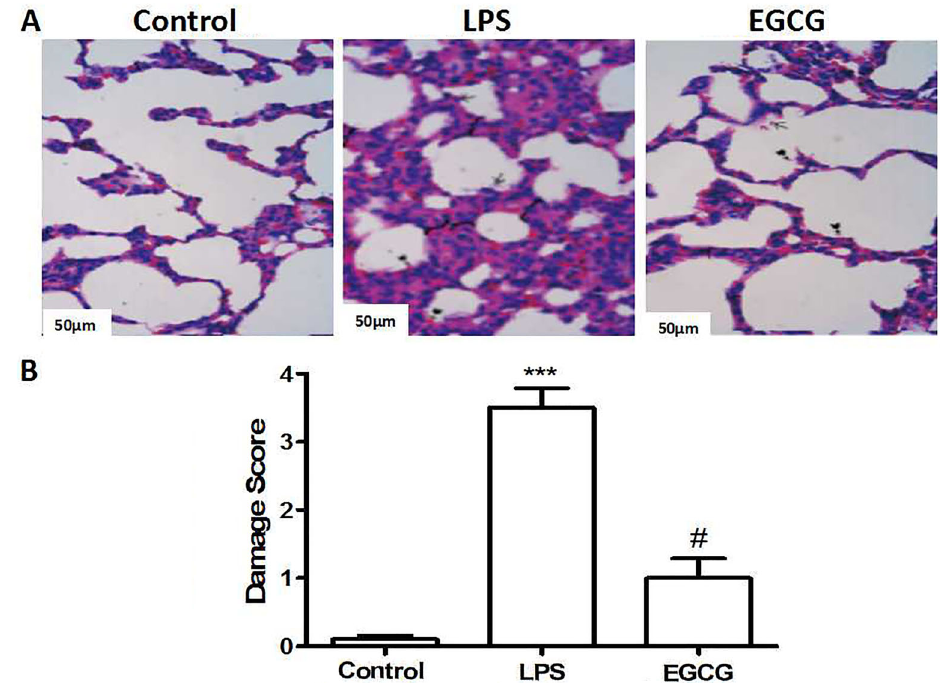
Figure 1. Effect of epigallocatechin-3-gallate (EGCG) pretreatment on lipopolysaccharide (LPS)-induced acute lung injury determined by histological damage score. A , Representative microphotographs using hematoxylin and eosin staining taken 72 h after LPS injection (bar: 50 m m). B, Semi-quantitative assessment of the histological lesions based on tubular necrosis. Data are reported as means ± SE (n=10). ***P o 0.001, compared to Control; # P o 0.05, compared to LPS (ANOVA). Table 3. Comparison of wet/dry (W/D) weight ratio and myeloperoxidase (MPO) activity of the three groups. Group